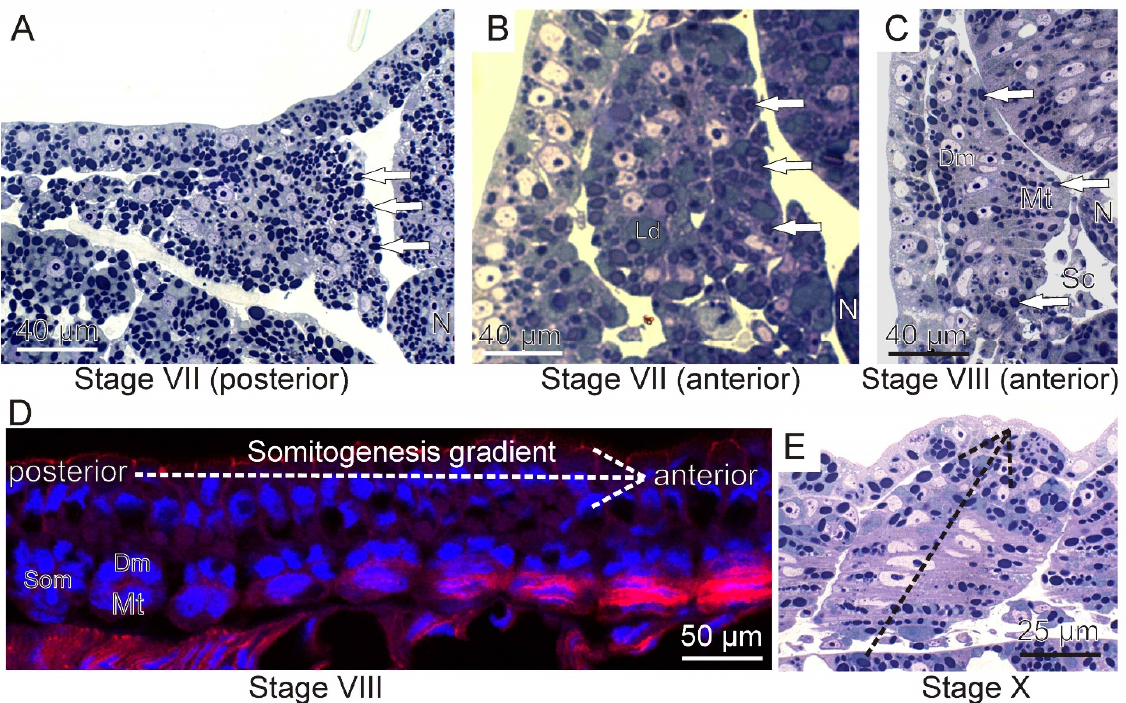
Figure 1. Early stages of river lamprey ( L. fluviatilis ) embryogenesis. Cross ( A – C ) and longitudinal ( E ) sections of trunk muscles are stained with methylene blue. ( D ) Longitudinal confocal section of trunk muscles. Nuclei (blue), actin (red). Yolk platelets (white arrows), notochord (N), lipid droplets (Ld), dermomyotome (Dm), myotome (Mt), sclerotome (Sc), somite (Som). The white dashed arrow shows a posterior–anterior gradient of somitogenesis. The black dashed arrow shows the mediolateral gradient of myoblast fusion in the myotome.